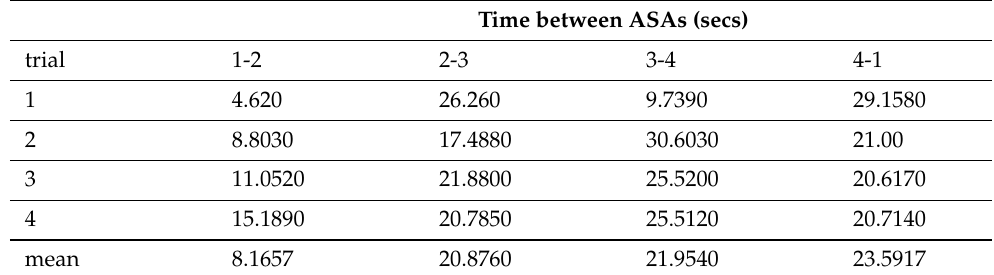
Table 1. The travel times between ASA waypoints for each trial with no obstacles.